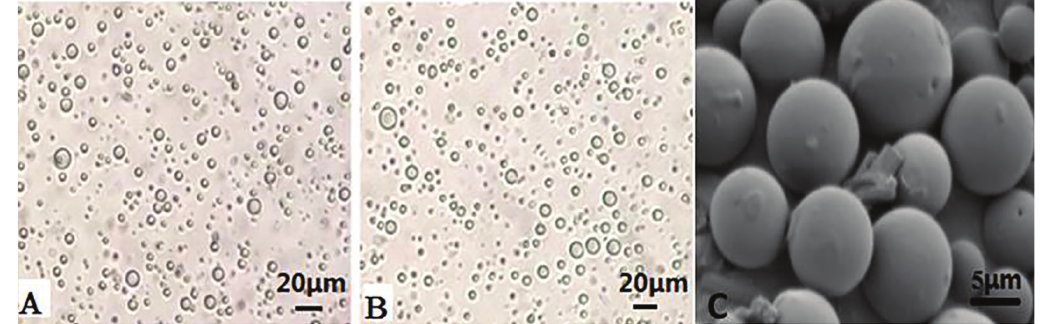
FIGURE 3 - Microscopy photograph of TDF loaded PLGA microspheres: (A) fresh-prepared; (B) suspension of freeze-dried powder; (C) the SEM of freeze-dried powder.